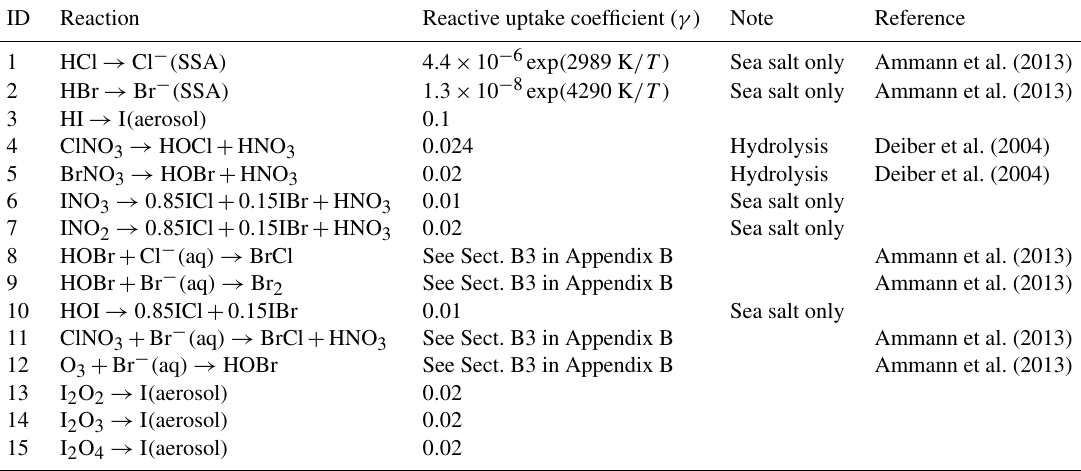
Table B4. Halogen multiphase reactions and reactive uptake coefficients ( γ ).